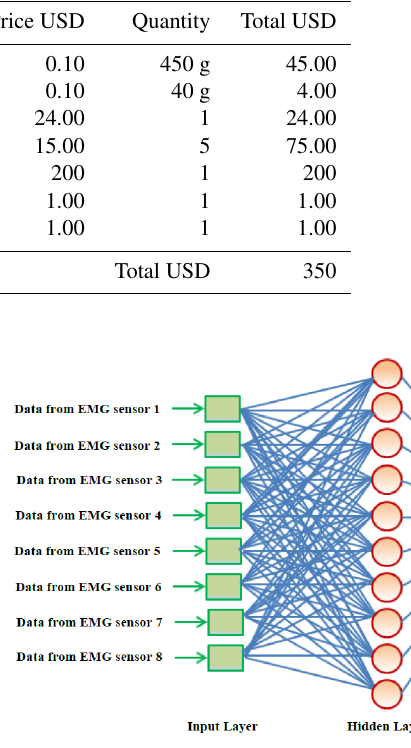
Figure 13. Algorithm structure artificial neural network with 8 in- put and 10 hidden